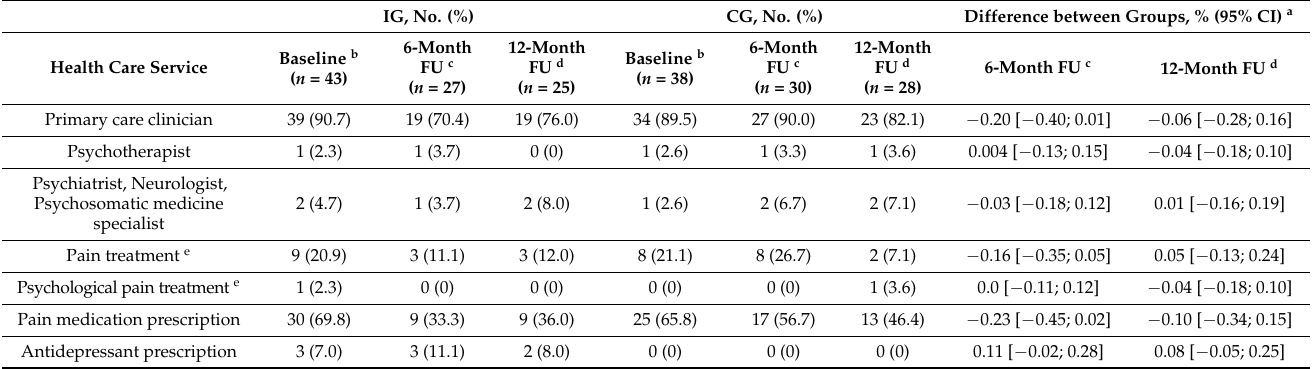
Table 3. Health care service use at 6-month (T2) and 12-month FU (T3).